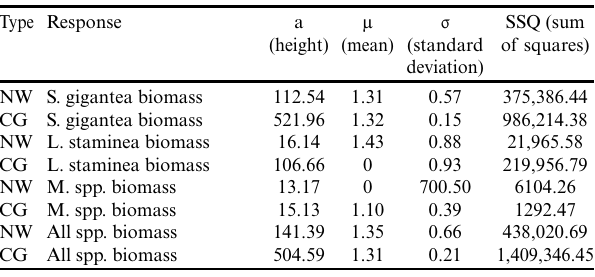
Table 3 . Parameters for the modeled response of biomass (g/0.0156 m³) of butter clam ( Saxidomus gigantea ), bentnose macoma ( Macoma spp.), native littleneck clam ( Leukoma staminea ), and total clam species as a function of intertidal height. Each response was predicted by modeling a gaussian curve to the data, y = a*exp(-0.5*((x-μ)/ σ )2), where y = response, x = intertidal height, a = height, μ = mean, and σ = standard deviation. NW = nonwalled, CG = clam gardens.